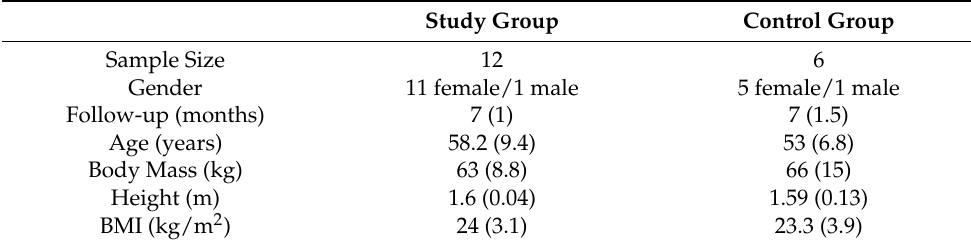
Table 1. General characteristics of the patients (Median (IQR)).